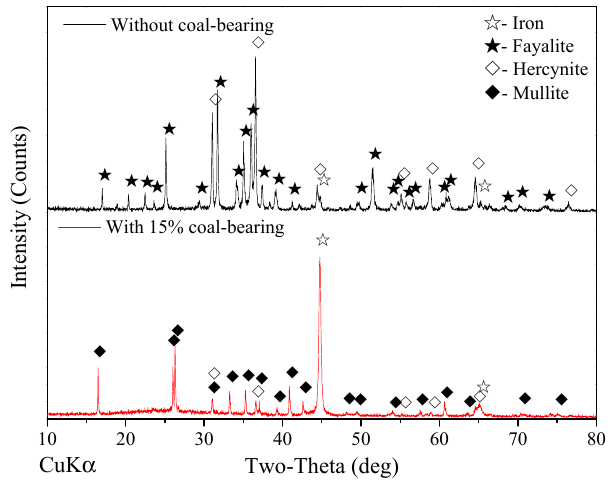
Figure 8. XRD patterns of reduced pellets with different coal ‐ bearing mass ratios (reducing at 1300 °C for 20 min with a total C/Fe mass ratio of 1.0).